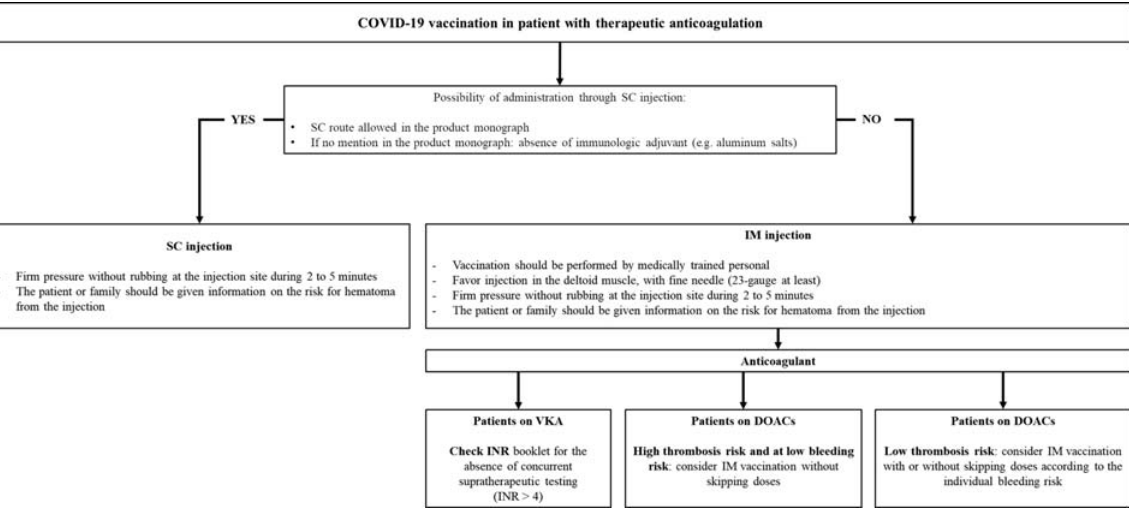
Fig. 1 Management of intramuscular vaccination in patients with therapeutic anticoagulation: example of COVID-19 vaccination. COVID-19, coronavirus disease 2019; DOAC, direct oral anticoagulant; IM, intramuscular; SC, subcutaneous; VKA, vitamin K